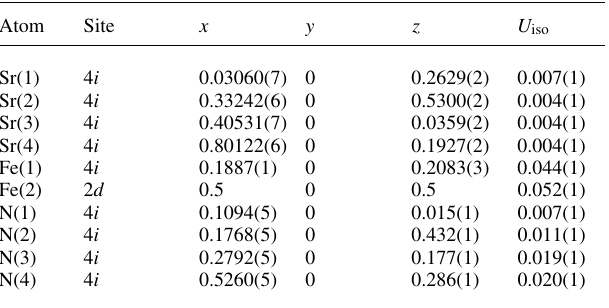
Table 2. Atomic coordinates and displacement parameters (in Å 2 )